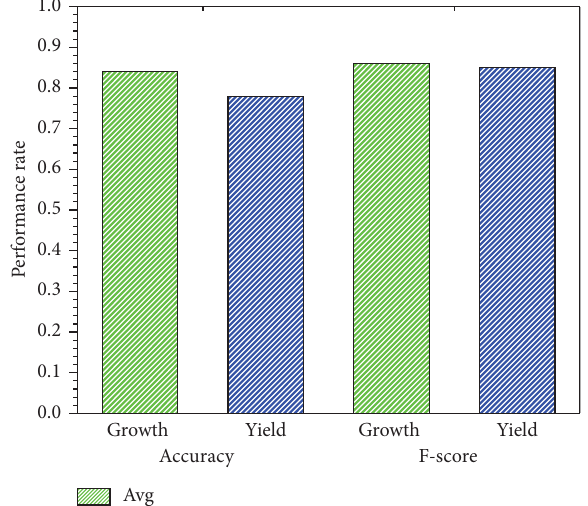
Figure 4: Average accuracy and F 1 score of all the applied ML algorithms on the basis of growth and yield metrics.